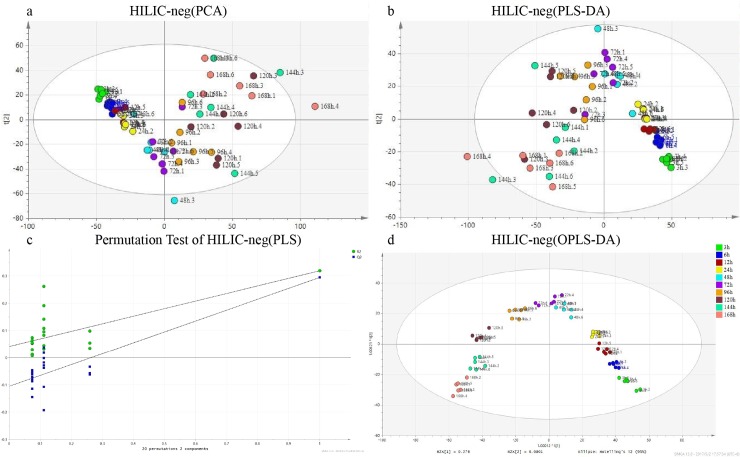
Metabolic analysis of the HILIC-neg dataset.(a) PCA analysis. The ellipse was obtained by Hotelling’s T2 with a 95% confidence interval. (b) PLS-DA analysis. (c) The permutation test plot in PLS-DA. (d) OPLS-DA analysis. Different colors were used to indicate the various periods of time after death. Each sample was nominated with both PMI and the intragroup sample number before and after the dot.